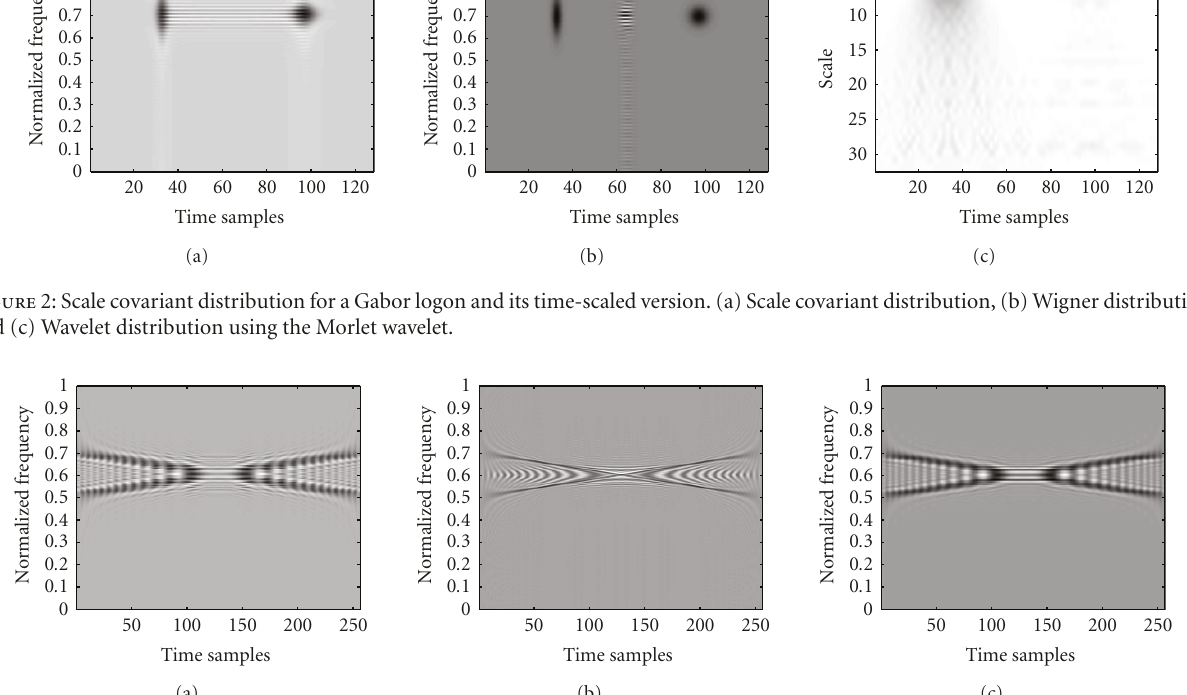
each other, that is, s ( n ) = exp( − ( n − n 0 ) 2 /σ )exp( − j 2 π ( n